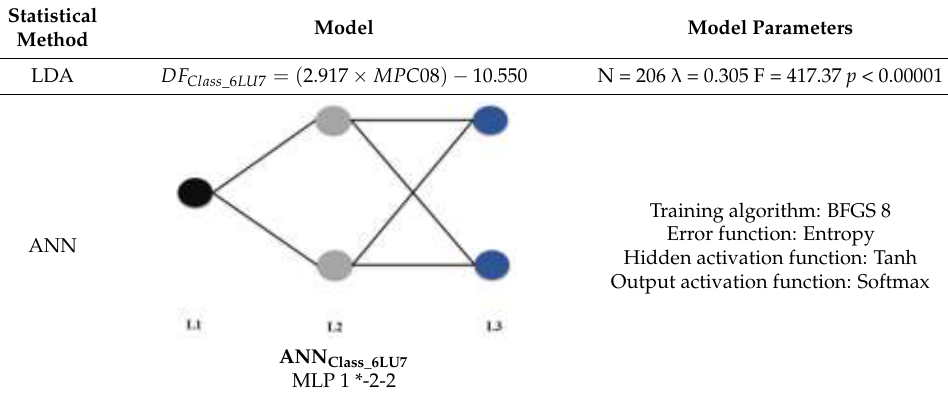
Table 1. Development of classification models to predict the anti-SARS-CoV-2 activity (protease inhibition activity).